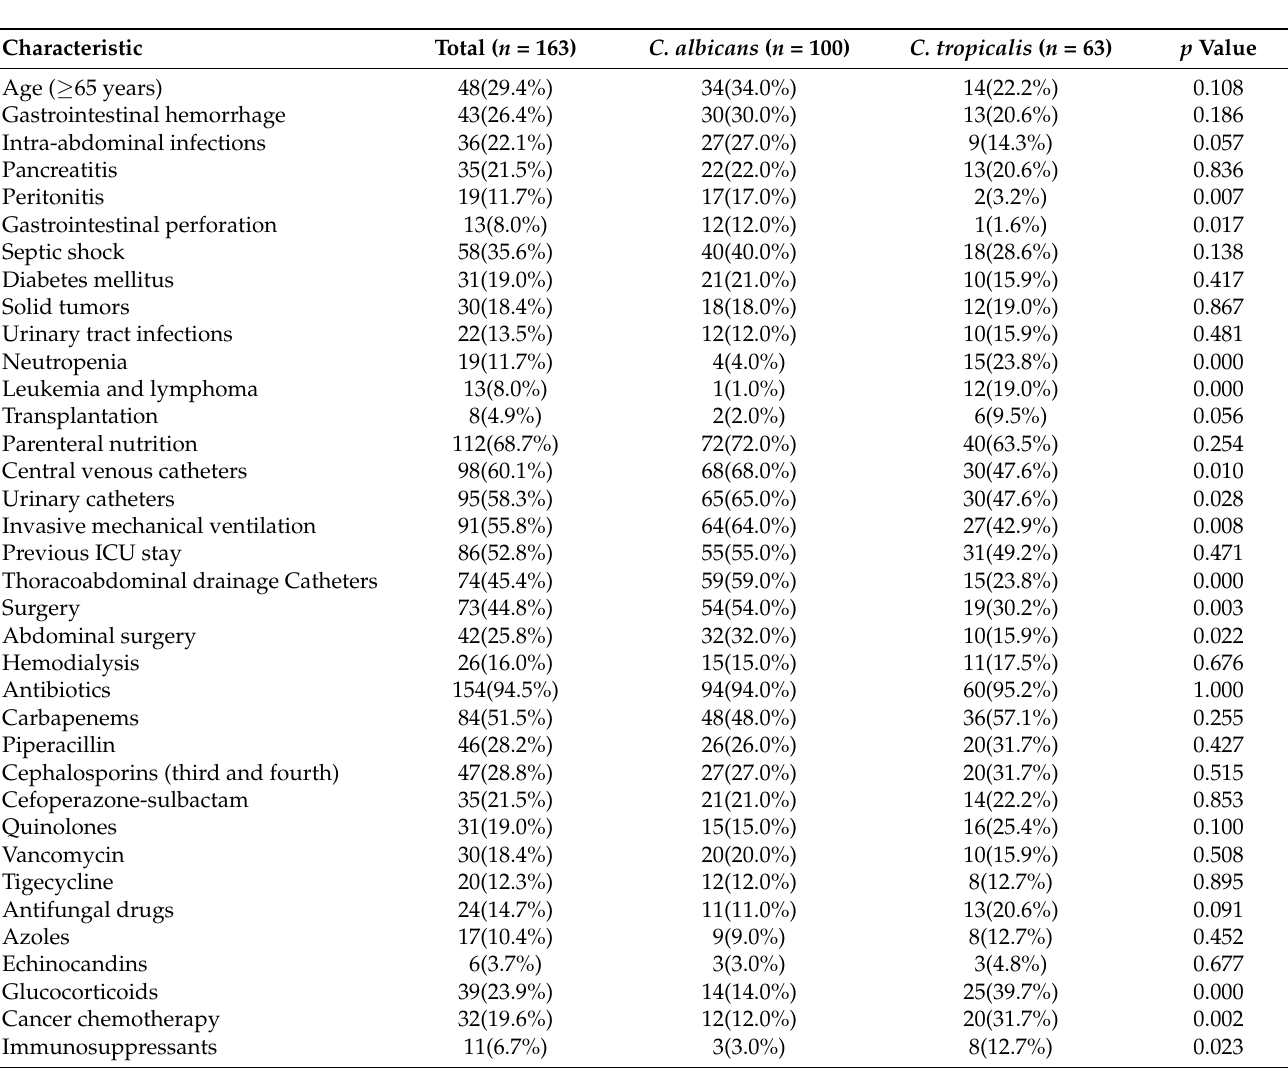
Table 6. Univariate analysis of factors with respect to patients with C. albicans vs. C.